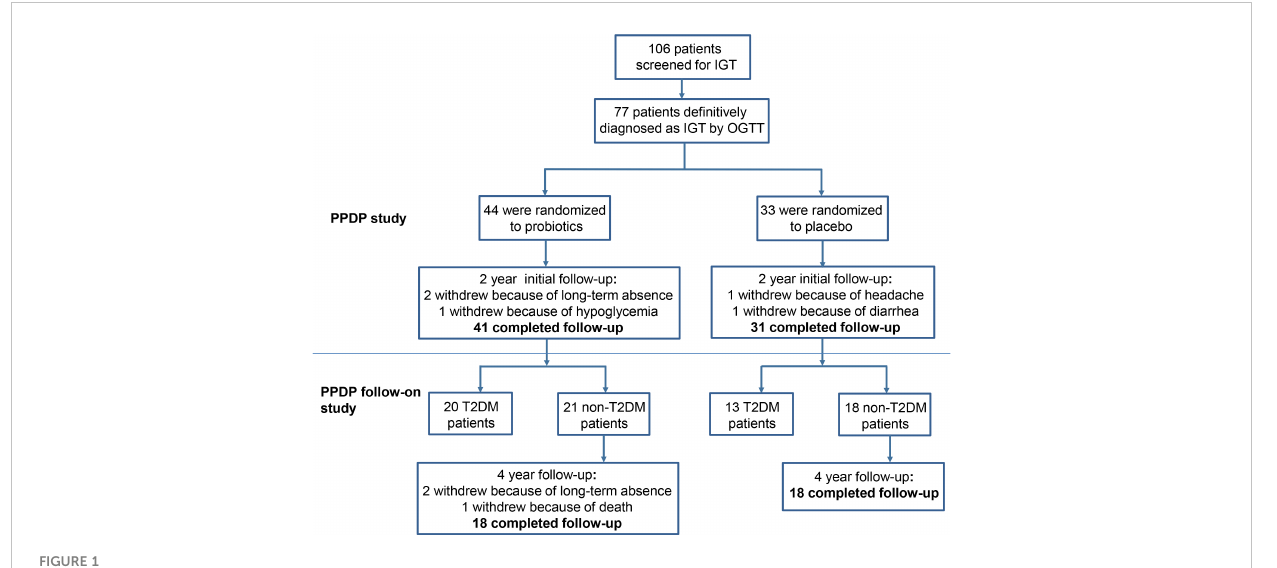
FIGURE 1 Flow diagram for PPDP follow-on